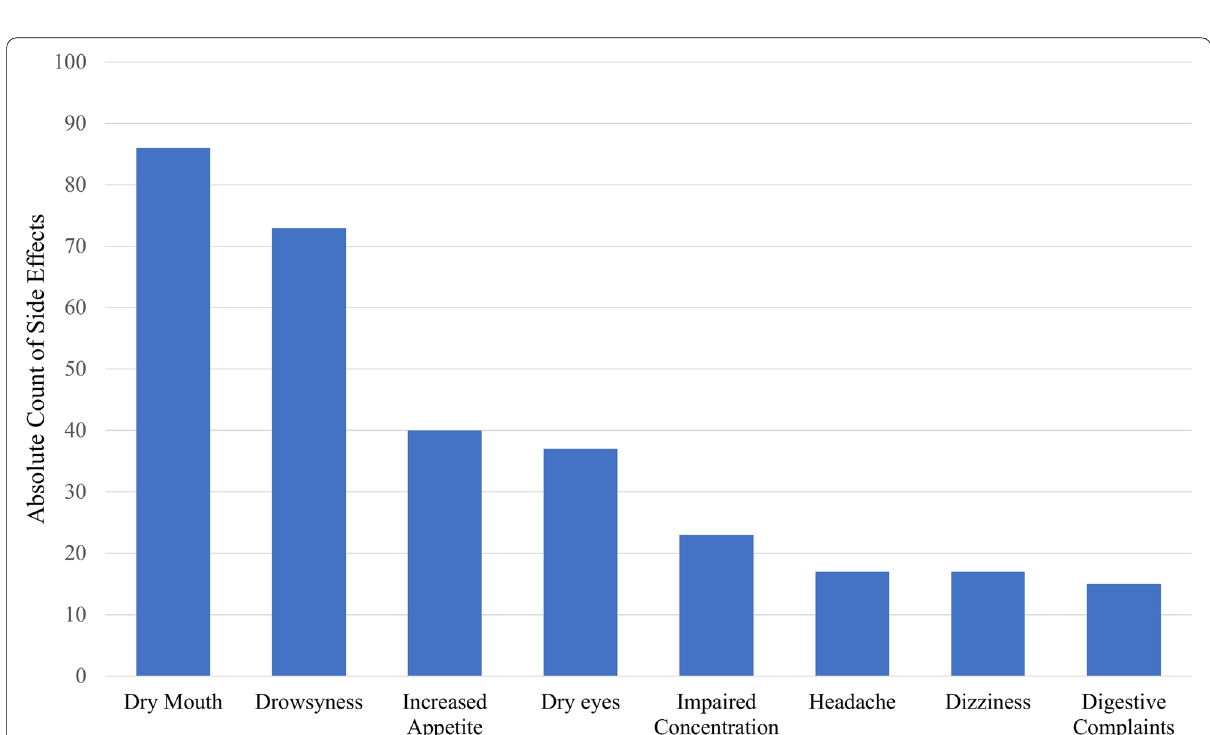
Fig. 3 Number of patients reporting the most common side